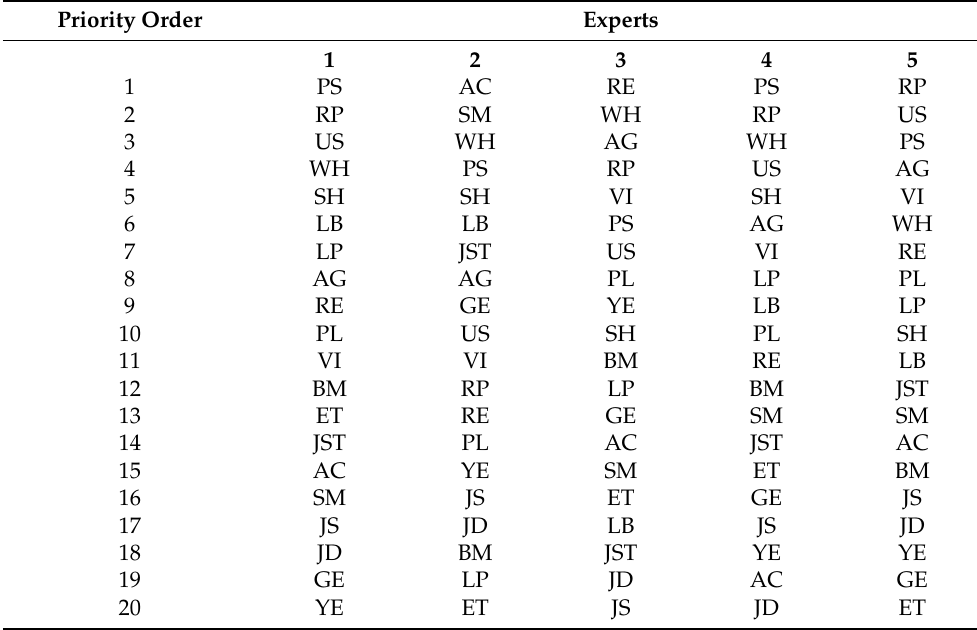
Table 6. Prioritization of MSDs’ risk factor based on experts’